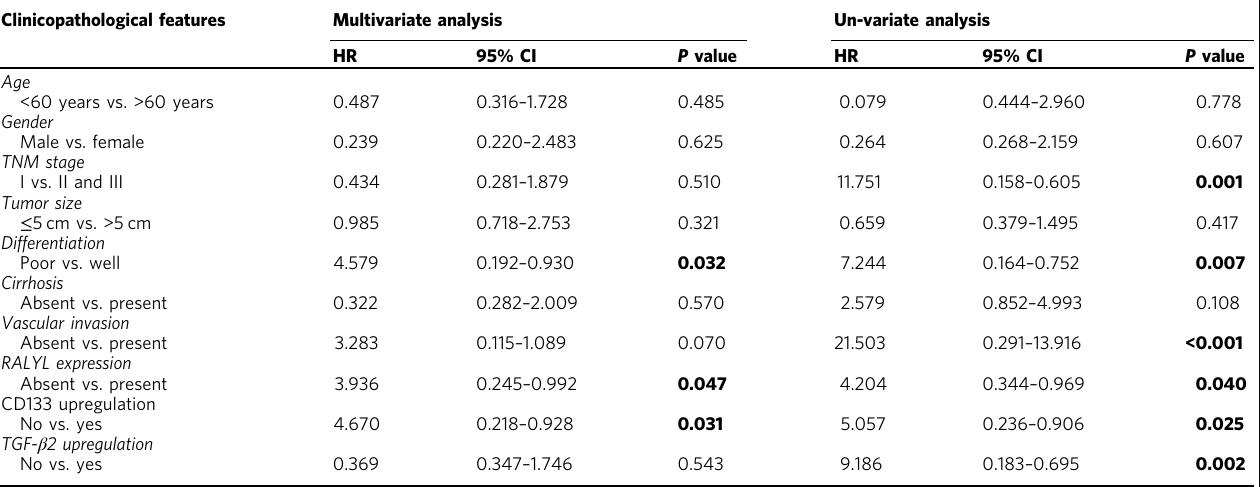
Table 2 Cox proportional hazard regression analyses for 5-year survival. Clinicopathological